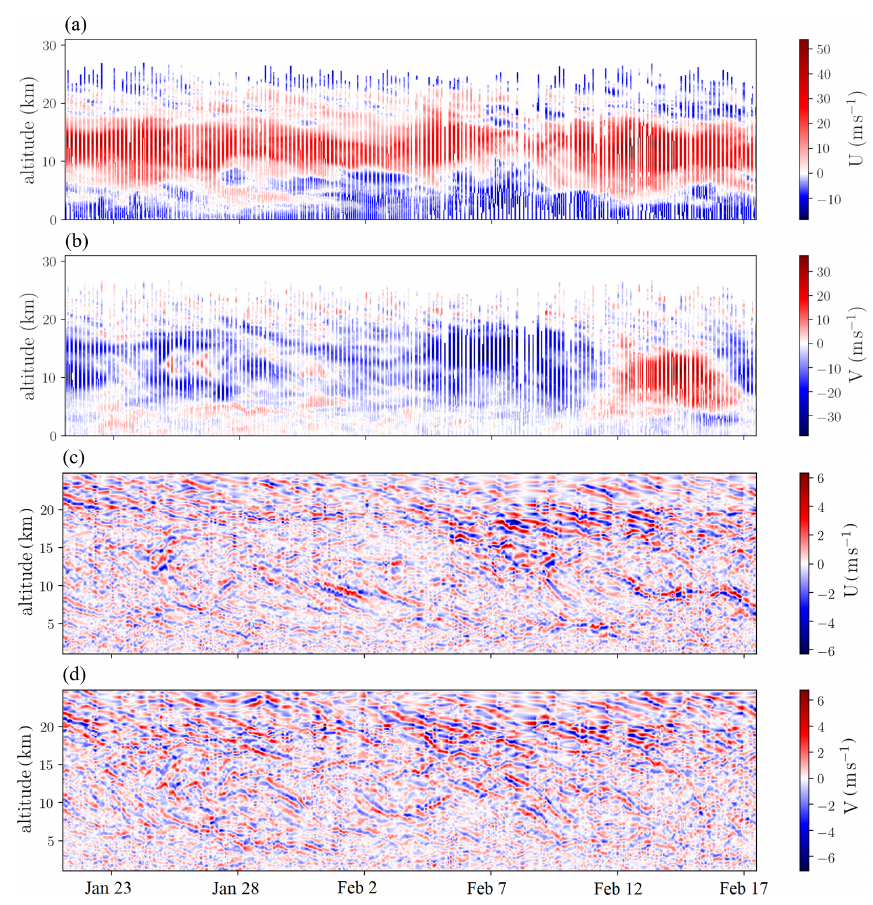
Figure 2. (a) Zonal and (b) meridional wind measured by ascending and descending soundings at the BCO. (c) Zonal and (d) meridional wind perturbations after filtering the raw measurements to 500m < λ z < 10km and 3h < τ <